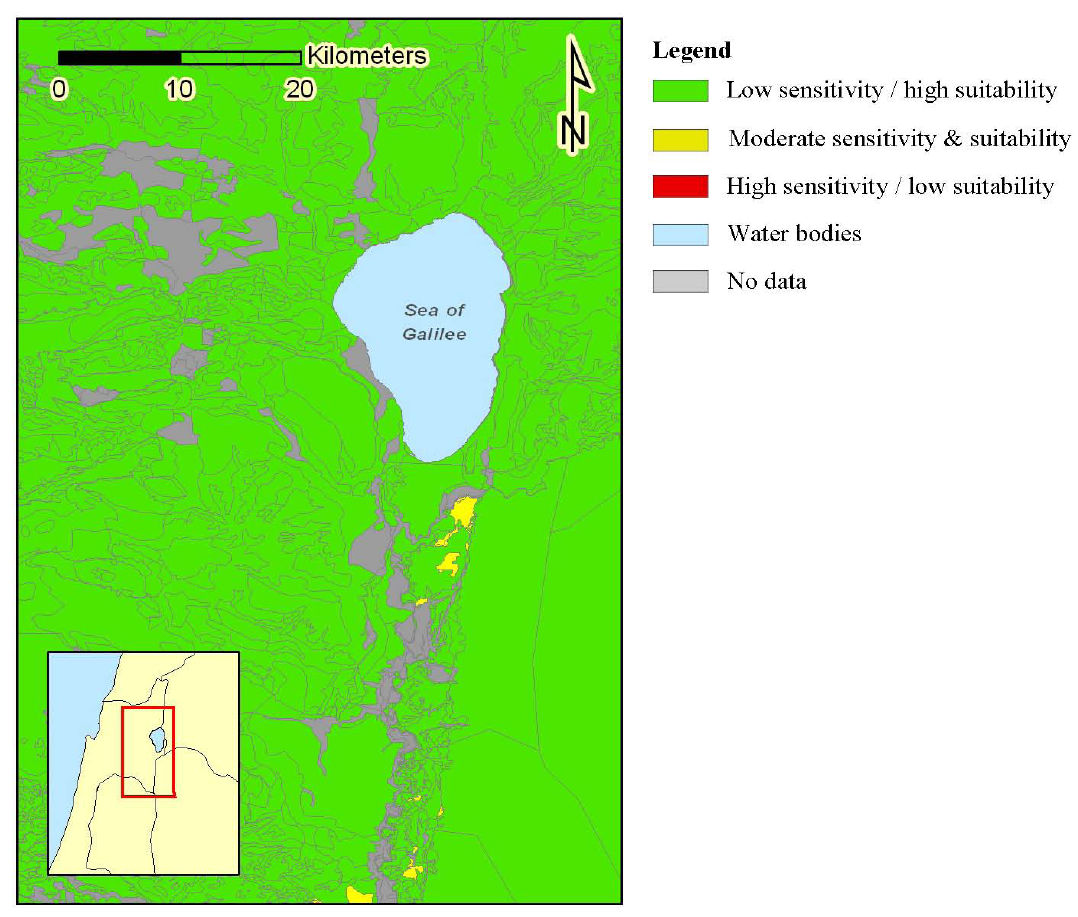
Figure 3. Cut-out of the risk assessment map visualizing sensitivity B: Sensitivity towards the slaking of the upper layer (scale 1: